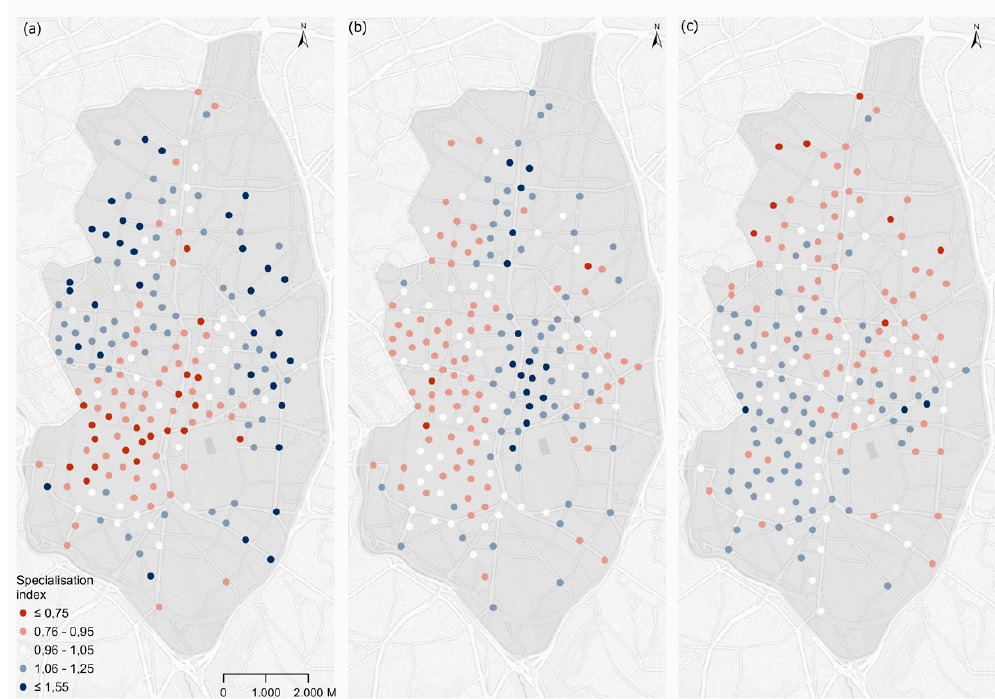
Figure 8. Reference Scenario: Level of specialization of the parking spaces by time band. ( a ) Morning. ( b ) Afternoon. ( c ) Night. Source: Authors’ own elaboration.